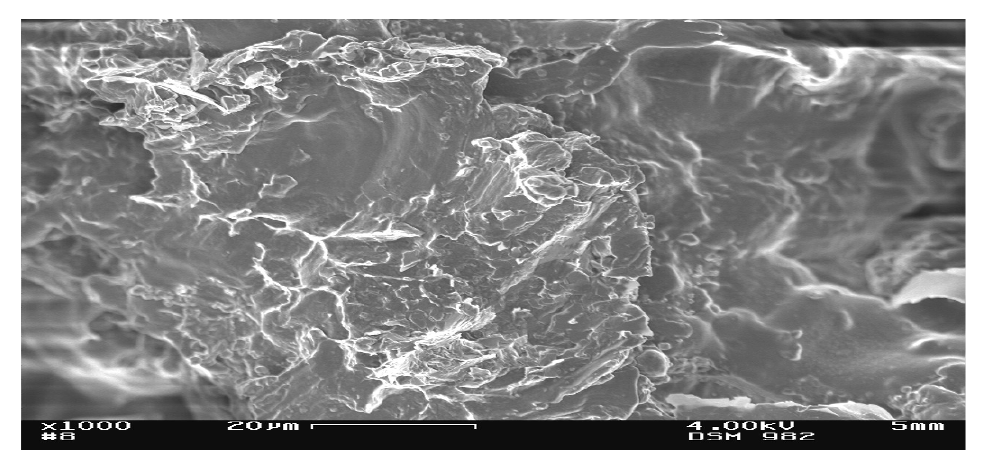
Figure 4. SEM analysis of sodium phosphate-hydroxy ethanolamide.